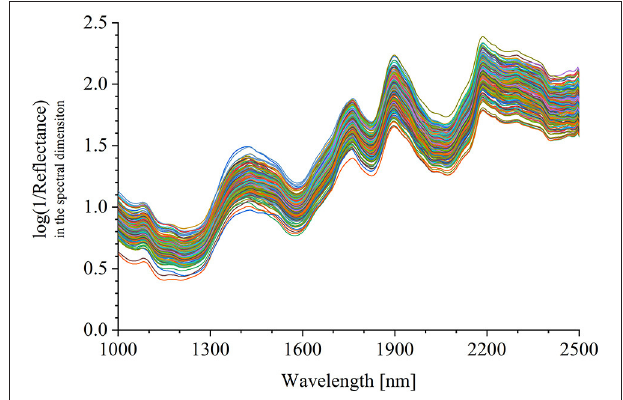
FIGURE 3 | The extracted average spectra of the 248 pomelo samples in the NIRHI spectral